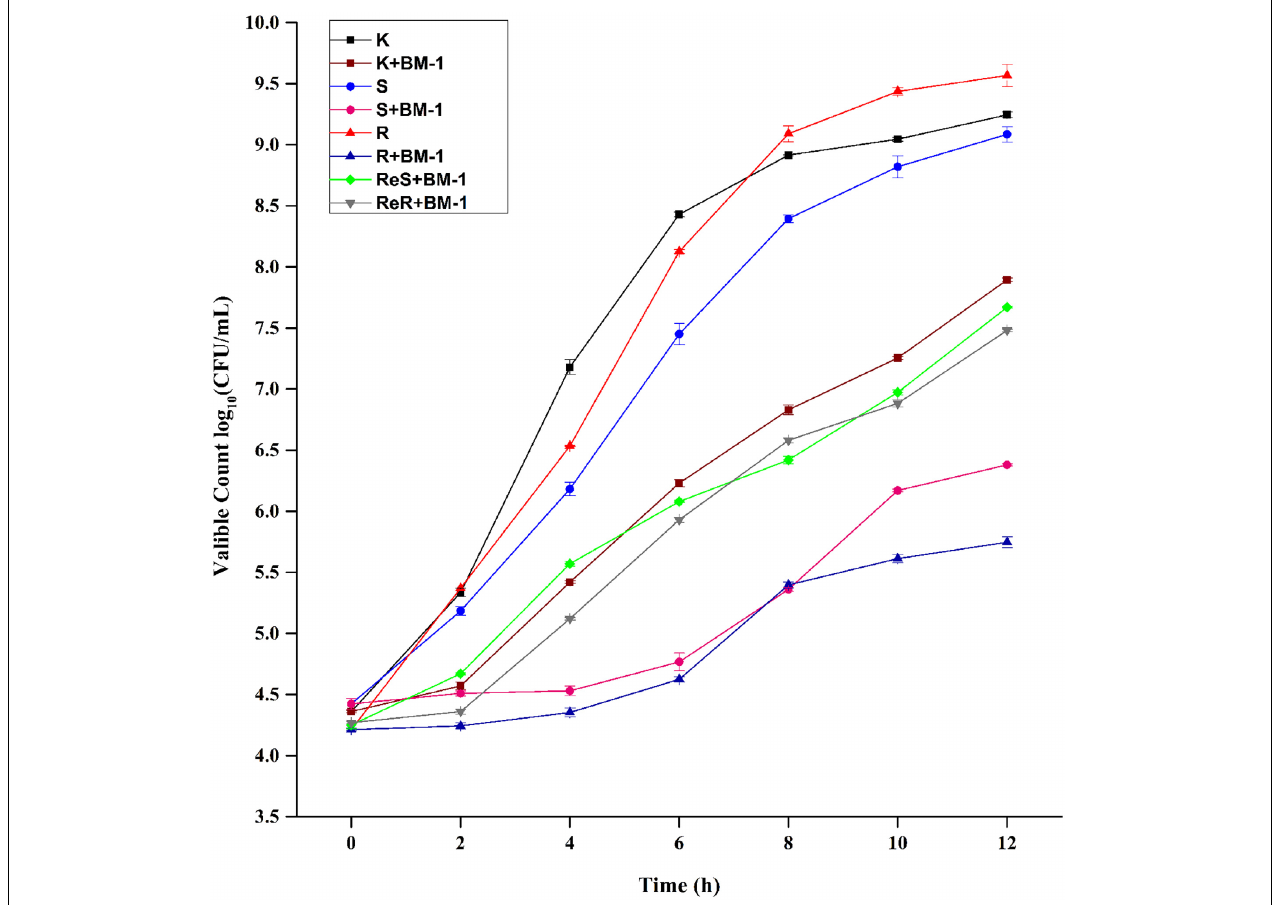
FIGURE 2 | Effects of plantaricin BM-1 on the growth of wild type E. coli K12 (K) and mutant E. coli JW4073 (S), E. coli JW4074 (R), E. coli ReJW4073 (ReS), and E. coli ReJW4074 (ReR).